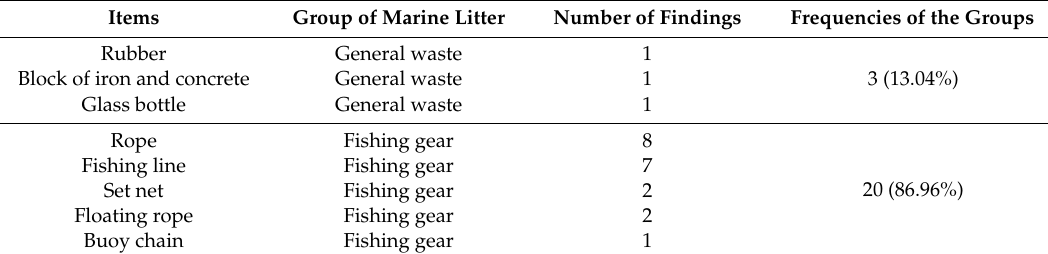
Table 2. Items of marine litter found in the study